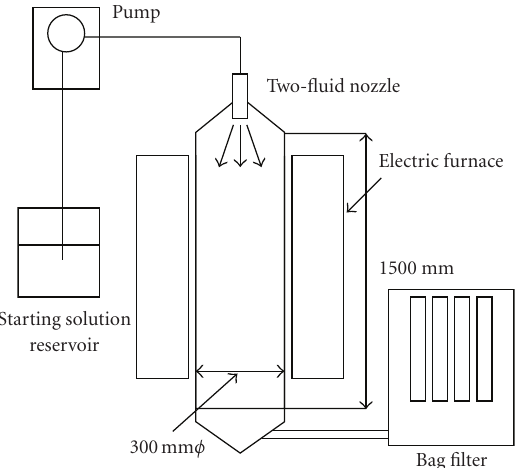
Figure 1: Schematic diagram of spray pyrolysis apparatus.